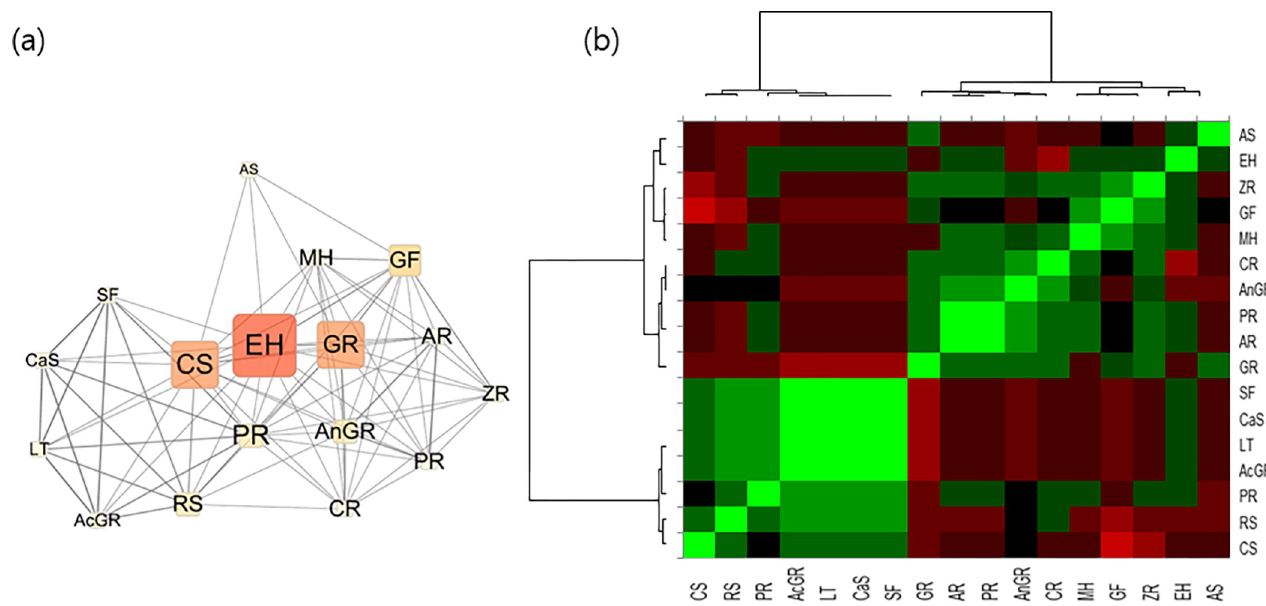
Fig 2. (a) 1-mode network of herbs in herbal prescriptions (b) Heatmap of Pearson’s correlation matrix of herbs in anti-obesity herbal prescriptions. AS, Armeniacae Semen; EH, Ephedrae Herba; ZR, Zingiberis Rhizoma; GF, Gypsum Fibrosum; MH, Menthae Herba; CR, Cnidii Rhizoma; AnGR, Angelicae Gigantis Radix; PR, Paeoniae Radix; AR, Atractylodis Rhizoma; GR, Glycyrrhizae Radix; SF, Schisandrae Fructus; CaS, Castaneae Semen; LT, Liriope Tuber; AcGR, Acori Graminei Rhizoma; PR, Platycodonis Radix; RS, Raphani Semen; CS, Coicis Semen.